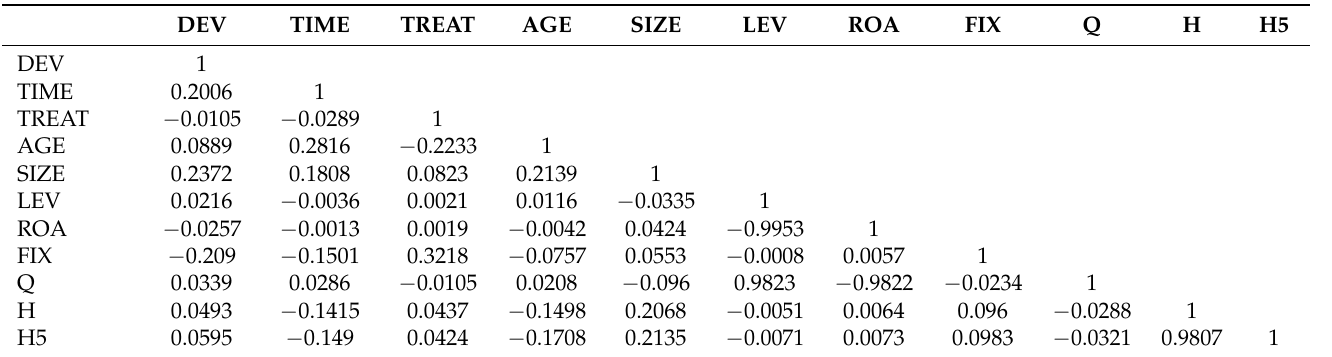
Table 5. Correlation matrix.